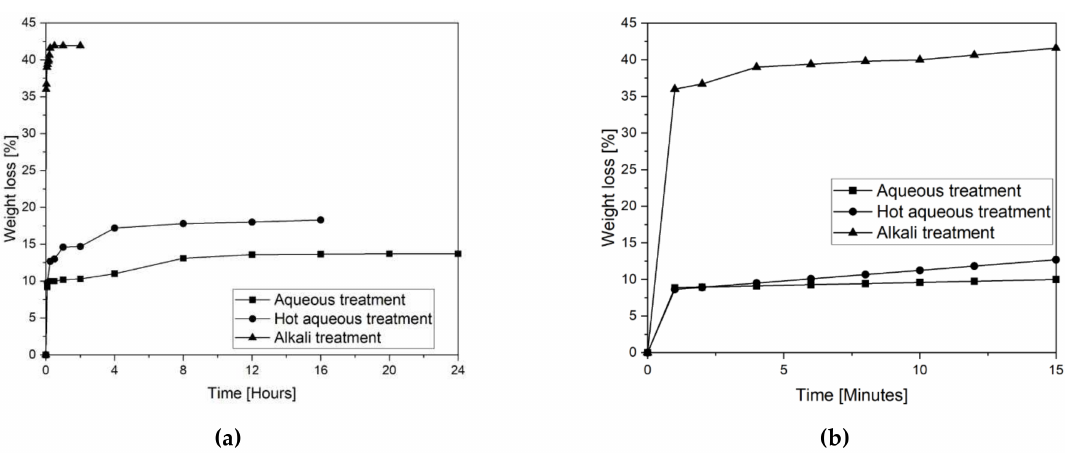
Figure 4. BS mass variation during different treatments ( a ) in 24 h ( b ) in the first 15